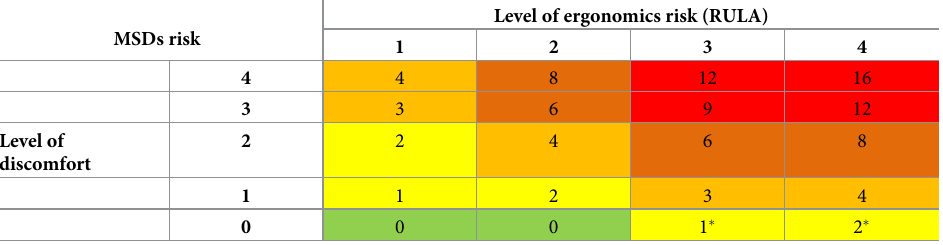
Table 1. Matrix of combined self-report discomfort level and RULA level derived MSDs risk